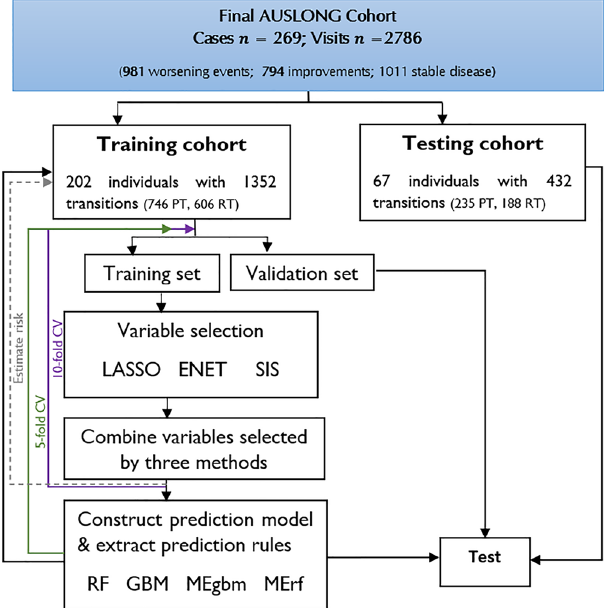
Figure 2. Outline of ensemble learning, and genetic risk prediction model construction. PT progressive transitions (“worsening” events); RT regressive transitions (“improved”